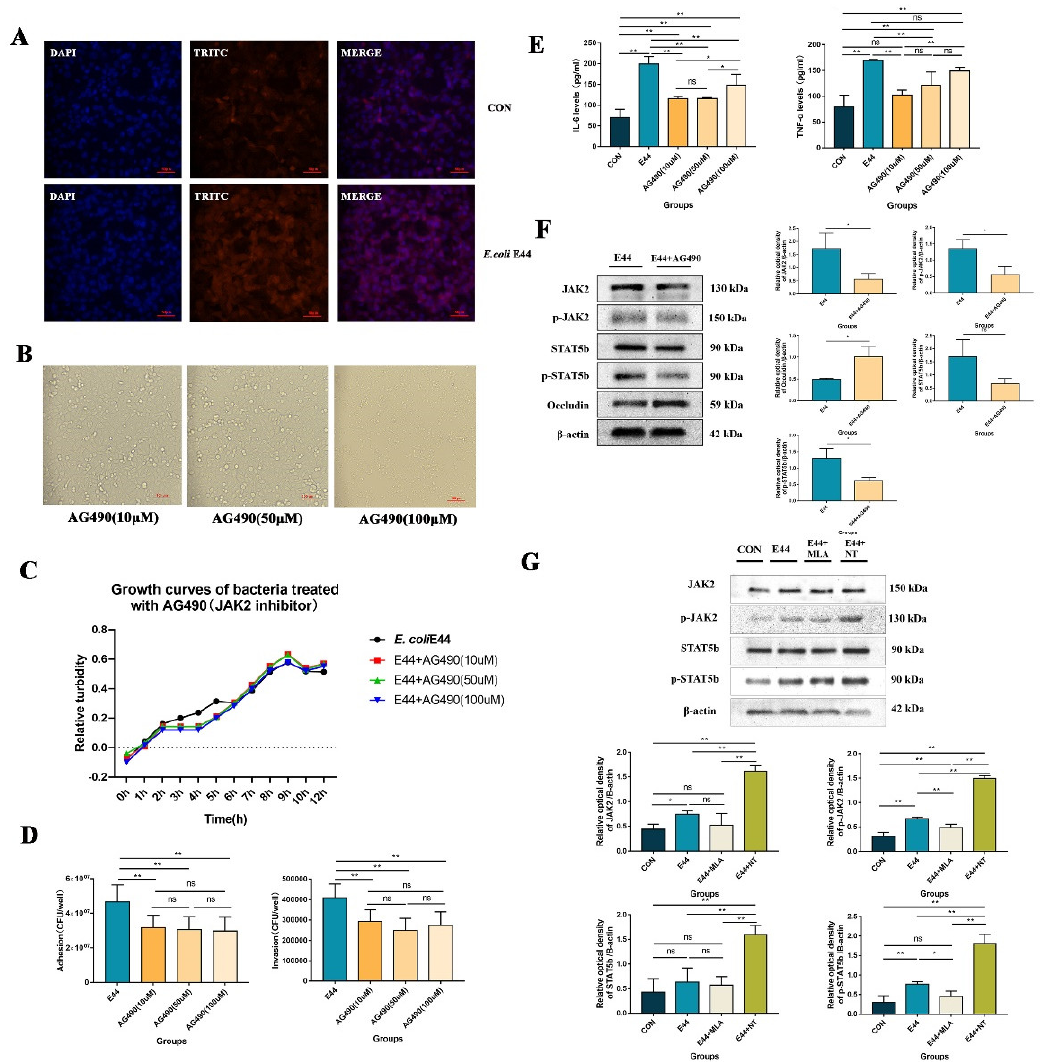
Figure 3. α 7nAChR-mediated JAK2/STAT5 signaling pathways activation in HBMECs infected Figure 3. α7nAChR-mediated JAK2/STAT5 signaling pathways activation in HBMECs infected with E. coli E44. ( A ) The expression of JAK2 in HBMECs infected with/without E. coli E44 detected by cell immunofluorescence, conducted by Axio Imager M2 software (Nikon, JPN). ( B ) Morphological ob- servations of HBMECs treated with different concentrations of AG490. ( C ) Antibacterial activities of AG490 on E. coli E44 were detected in vitro. ( D ) Adhesive, invasive abilities of E. coli E44 infected to HBMECs pretreated with different concentrations of AG490. ( E ) The expressions of IL-6 and TNF- α in HBMEC cells’ supernatant with AG490 when infected with E. coli E44. ( F ) The expressions of p-JAK2, p-STAT5b, and Occludin proteins in HBMECs with/without AG490 when infected with E.